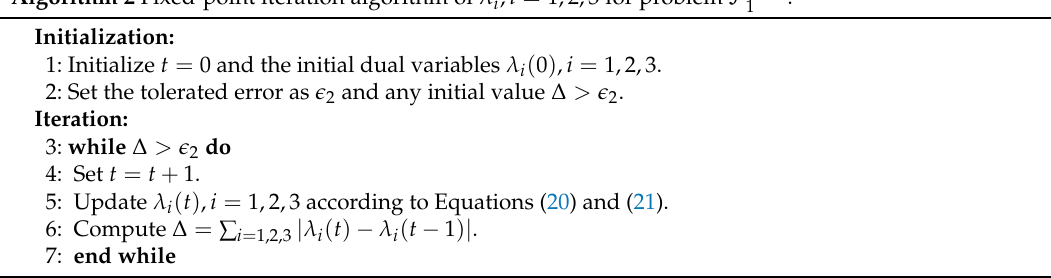
Algorithm 2 Fixed-point iteration algorithm of λ i , i = 1,2,3 for problem F Dual